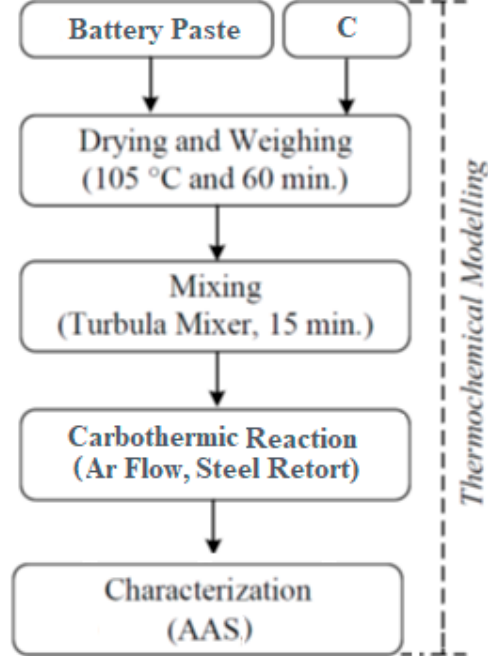
Figure 1. Flowchart of the Ar aided experimental studies.